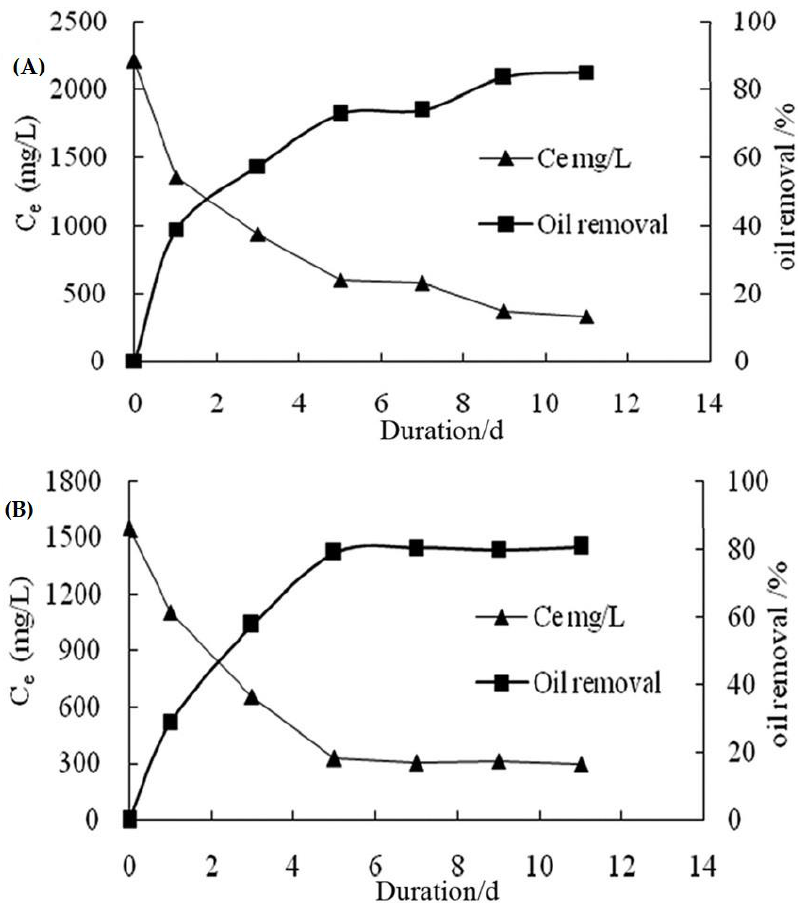
Figure 8. The biodegradation rate of the Diesel oil (LD) ( A ) and heavy oil (HO) ( B ) varies over time. x -axis (C e ) is the concentration of the residual oil after microbial degradation. Y-axis is the duration of incubation in days. Adapted from Zhou et al. [118].